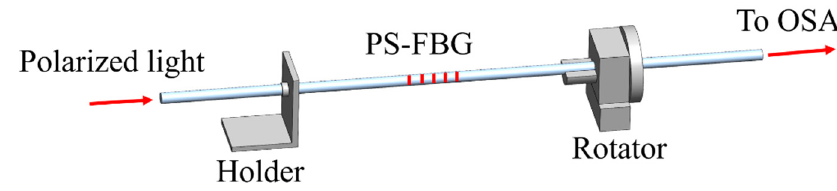
Figure 13. Torsion test device.